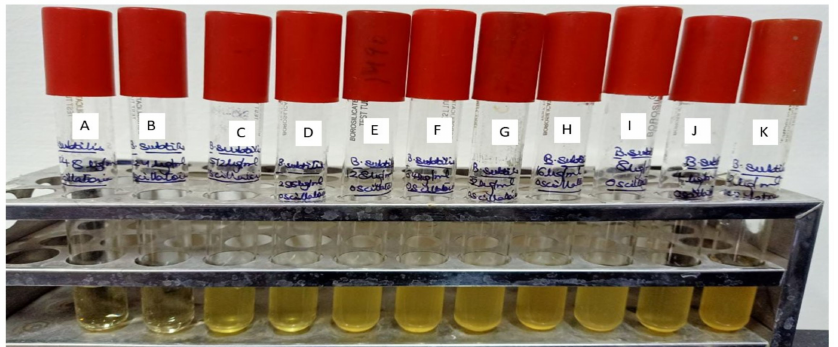
Figure 11. Minimum inhibitory concentration of Methanolic extract of Oscillatoria against Bacillus subtilis (MTCC 441) Muller Hinton agar broth tubes A to K dilution range from 1024 to 1 µ gmL − 1 .